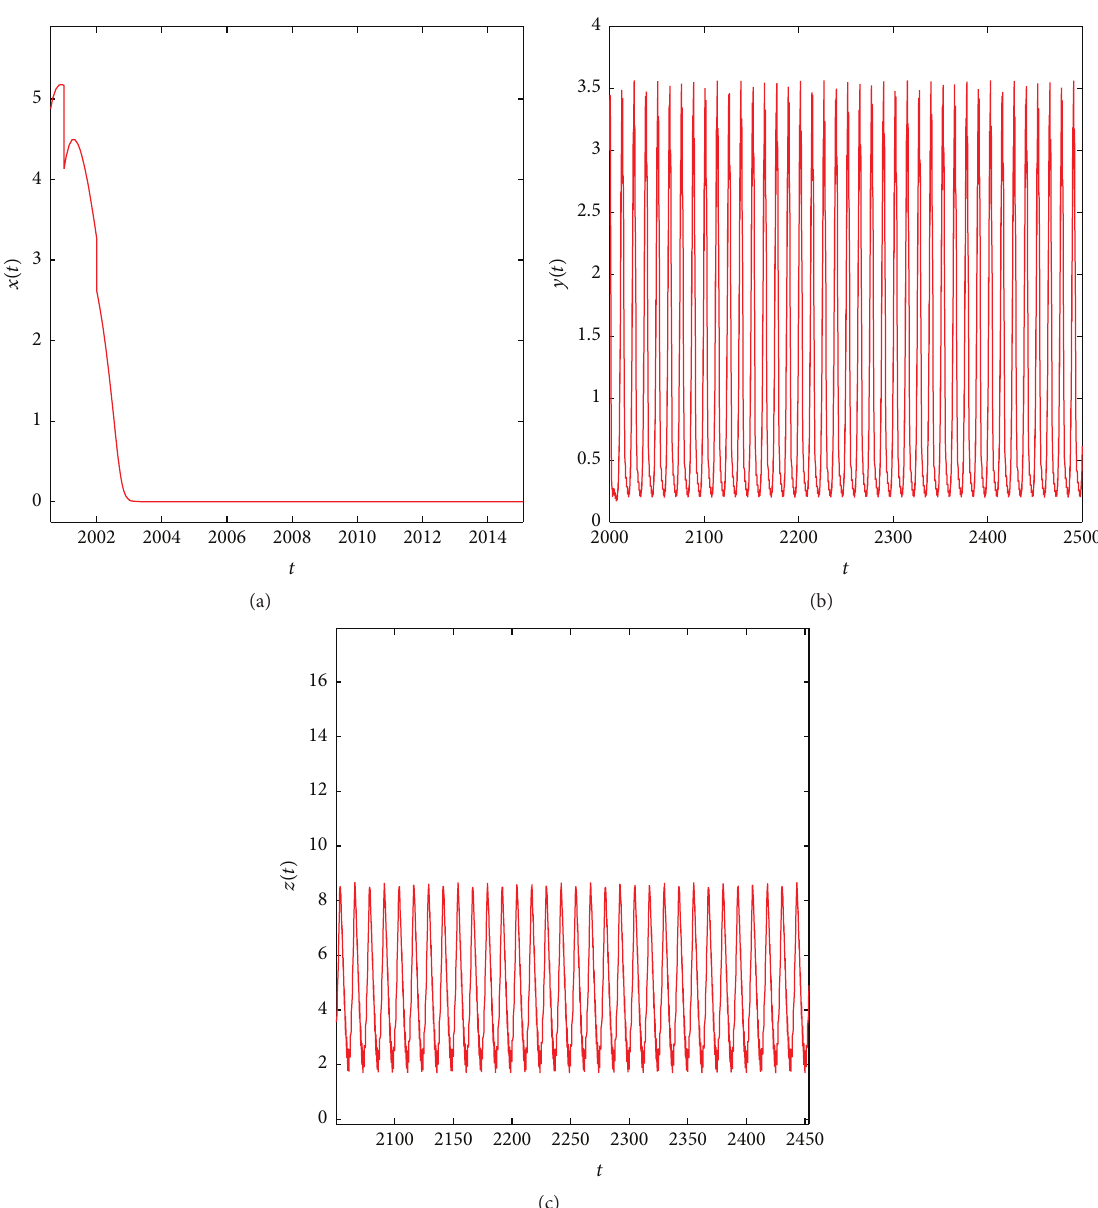
Figure 11: (a) Time series showing decay of 𝑥(𝑡) population, (b) time series showing relatively high biomass density of 𝑦(𝑡) population, and (c) time series showing low biomass density of 𝑧(𝑡) population of system (2) with mixed Holling type II-III functional responses ( 𝑝 = 1 , 𝑞 = 1 , 𝑠 = 2 , and 𝑟 = 2 ) in presence of seasonal perturbation with data set (45) and 𝑃 = 1.2